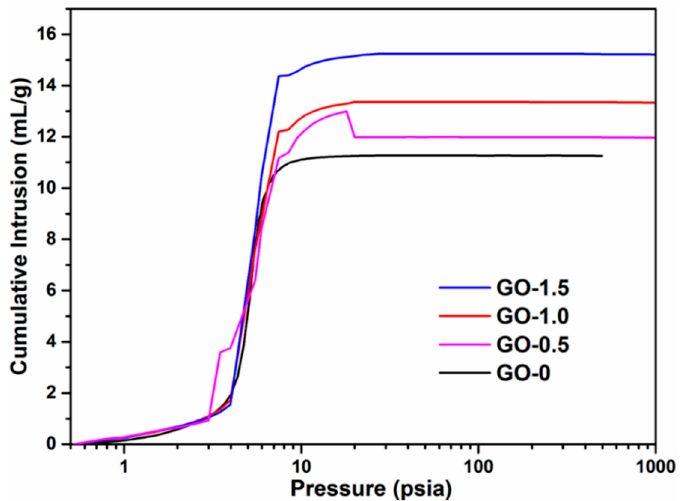
Figure 2. SEM images of the CSAs/GO aerogels. ( a ) GO-0, ( b ) GO-0.5, ( c ) GO-1.0, ( d ) GO-1.5, and the insets are selected magnifications.